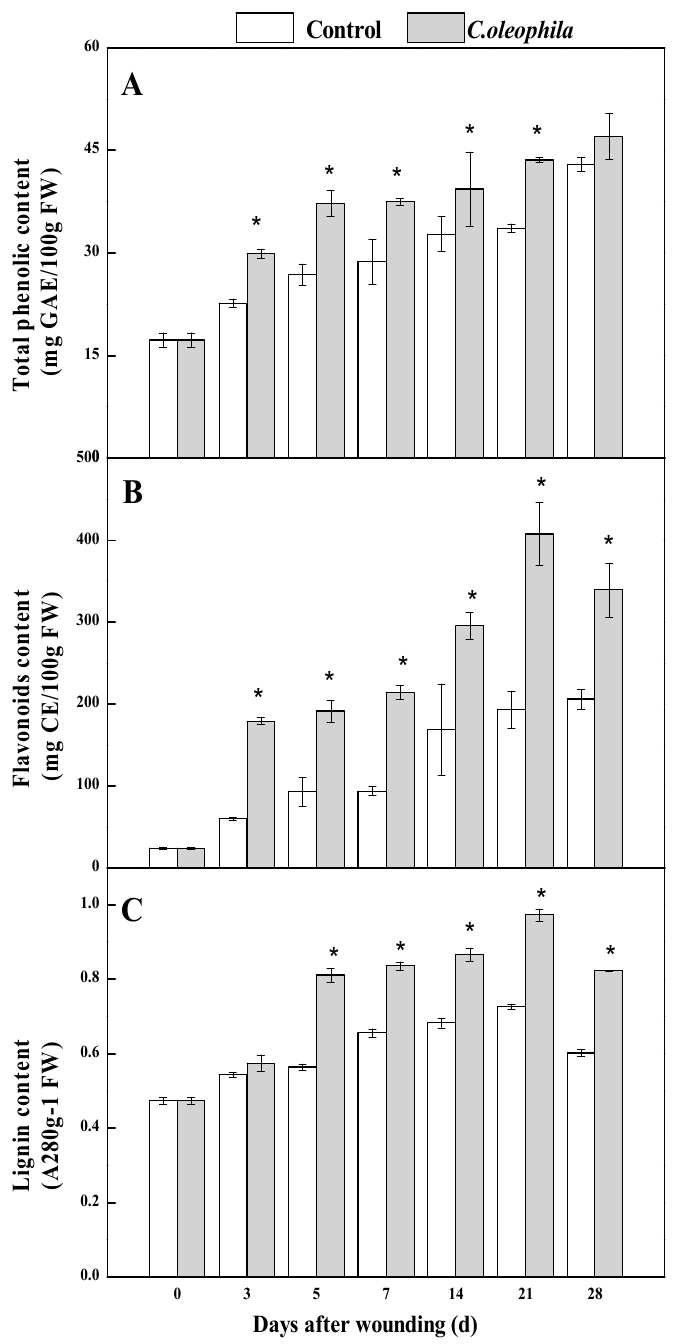
Figure 5. Effects of C. oleophila treatment on the content of total phenolic ( A ), flavonoids ( B ), and lignin ( C ) at wound sites of tubers during healing. Bars indicate standard error ( ± SE). Asterisks indicate significant difference ( p < 0.05).